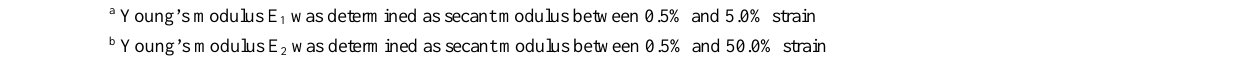
Table 2: Mean values for mechanical properties obtained from the uniaxial tensile tests for the two silicone adhesives. Failure stress σ max,eng Young’s modulus E 2 b Failure strain ε max,eng Young’s modulus E 1 a Adhesive [MPa] [MPa] [MPa] [-] Dow Corning ® 993 2.25 2.21 3.05 1.34 Sikasil ® SG-550 2.84 2.77 3.12 1.46